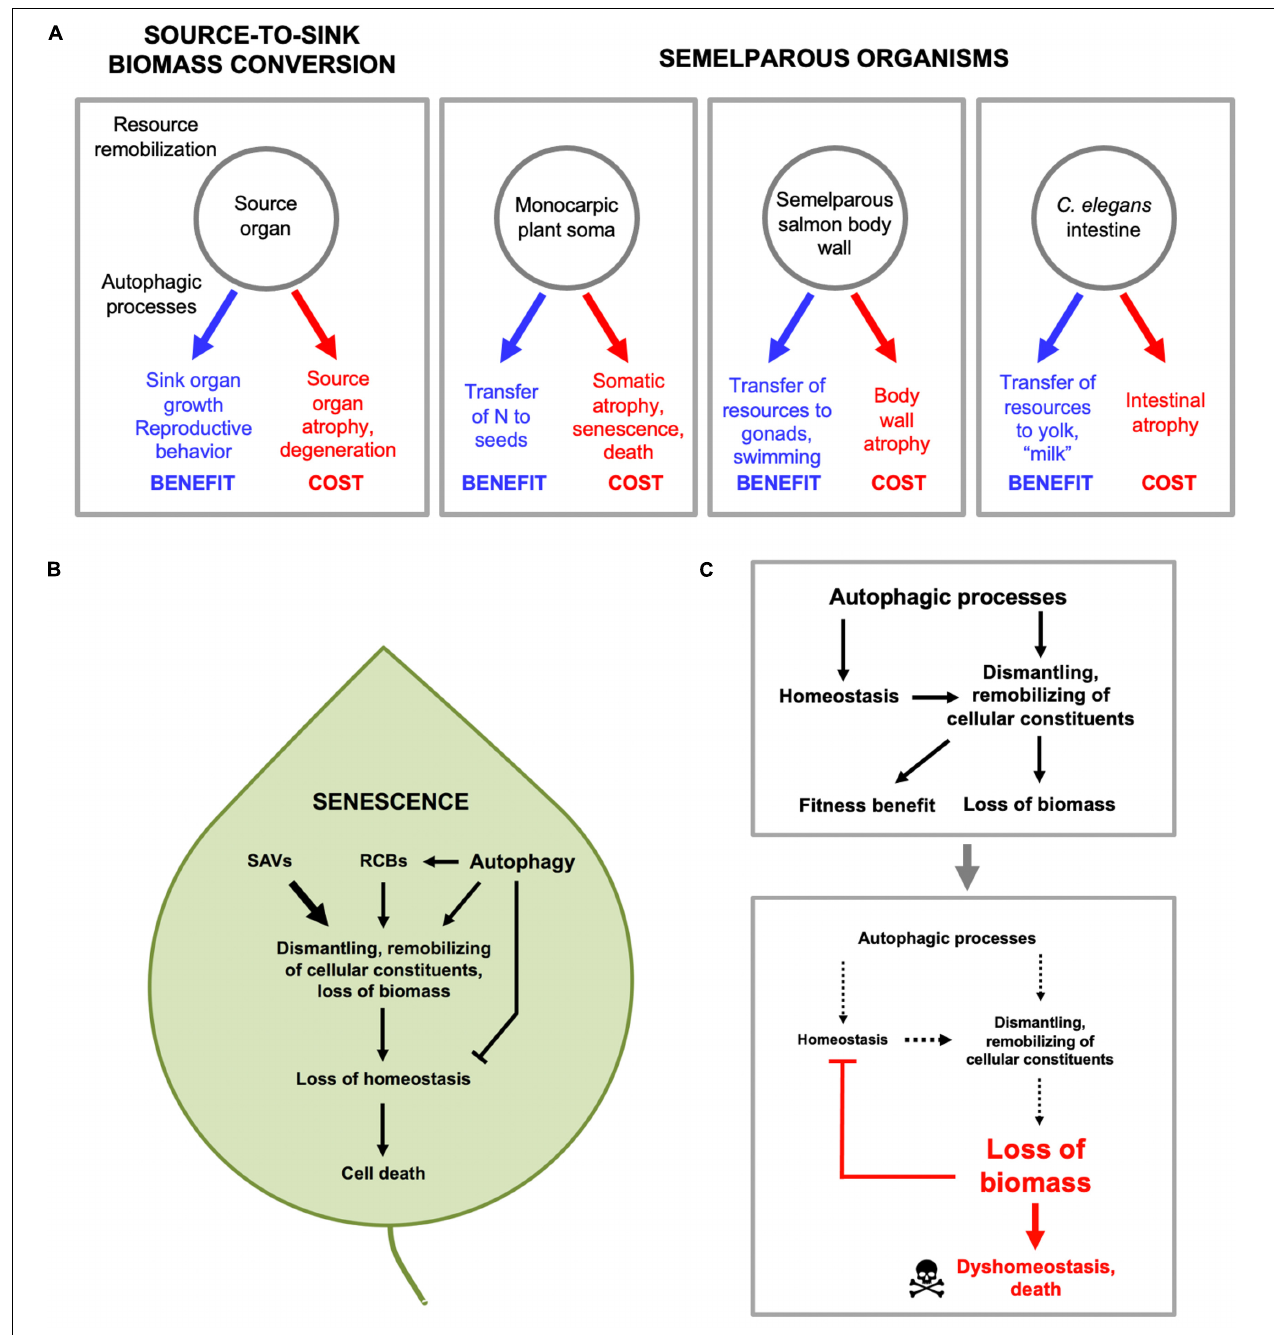
FIGURE 4 | Source-to-sink biomass conversion and physiological costs that cause pathology. (A) General form of source-to-sink biomass conversion (left) and three examples. In each case remobilization of resources lead to fitness benefits by supporting reproductive processes, but leads to atrophy and eventual pathology in source organs. (B) Autophagic processes and senescence in plants. Material from other organelles, particularly chloroplasts, is transported to the vacuole in several ways, including autophagosomes. First, via autophagosomes, double membrane-bound vesicles as found in animal and fungal autophagy pathways (Marshall and Vierstra, 2018). Second, via double membrane-bound rubisco-containing bodies (RCBs; rubisco is the most abundant stromal protein in chloroplasts) which contain fragments of chloroplast proteins (Chiba et al., 2003), and whose transport to the vacuole is dependent on genes of the autophagy pathway (Ishida et al., 2008; Wada et al., 2009). Third, via senescence-associated vacuoles (SAVs) which are single membrane bound and which, unlike autophagosomes, contain high levels of protease activity (Martinez et al., 2008). (C) Autophagic processes protect in order to destroy (demolition engineer principle). A hypothesis based on recent progress in understanding the role of autophagy in plant leaf senescence (Avila-Ospina et al., 2014) (with thanks to Prof. Céline Masclaux-Daubresse). Top: by maintaining homeostasis during the systematic destruction of the cell, autophagic processes aid in its destruction. Bottom: eventually the cell is dismantled to the point that even autophagic processes cannot be sustained, and homeostasis collapses, leading to death.